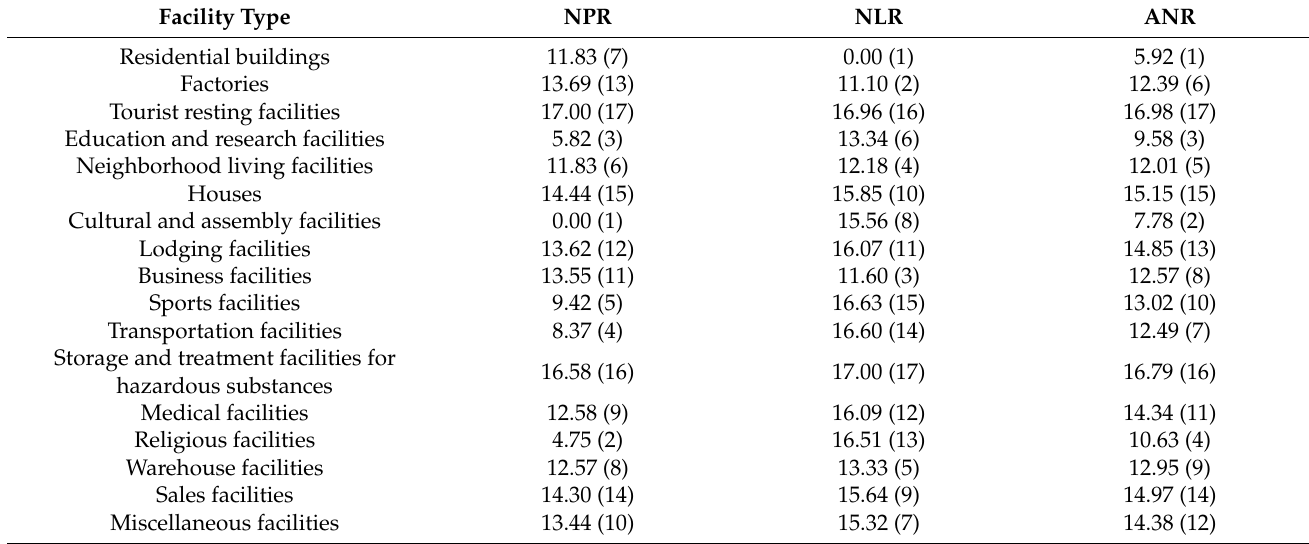
Table 6. Calculation of risk ranking for 17 construction facility types using normalized